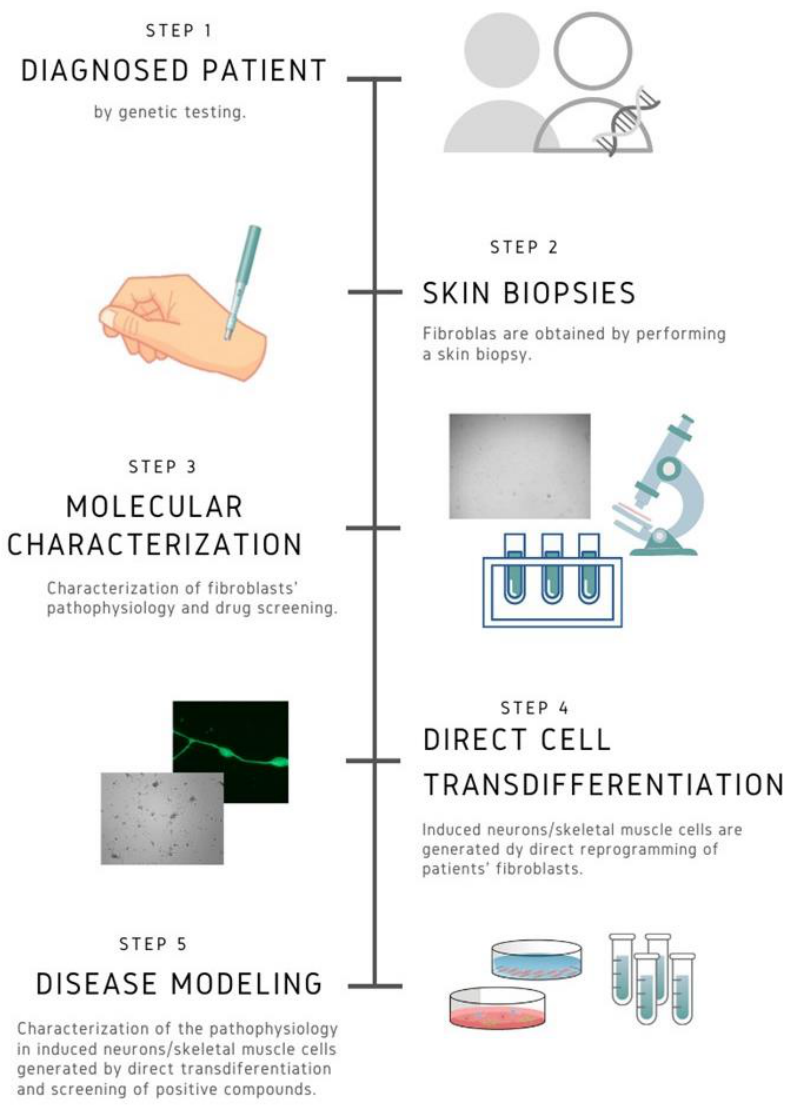
Figure 1. Work flow in personalized medicine. Fibroblasts and induced neurons or skeletal muscle cells derived from patients allow the characterization of the pathophysiological alterations in the patient’s own cells and in the most a ff ected cell types. This approach gives the opportunity of evaluating personalized treatment options, taking into account the particular mutation and the genetic background of the